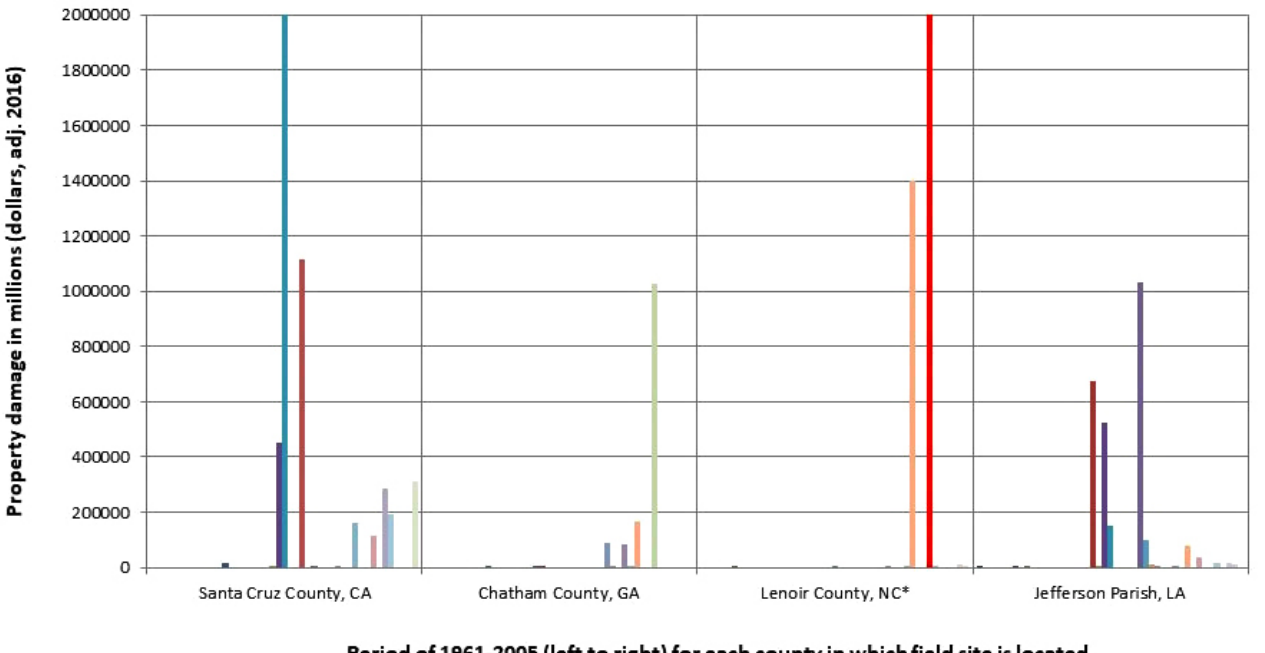
Fig. 2 . Property damage time series, 1961–2005 (CA: California; GA: Georgia; NC: North Carolina; LA: Louisiana) (Source: